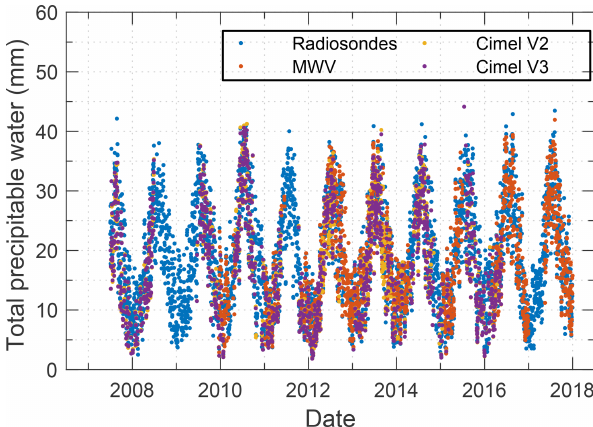
Figure 2. Time series of the daily mean values of the total pre- cipitable water during the period 2007–2017 based on measure- ments from radiosondes (blue dots), a microwave radiometer (or- ange dots), and Cimel sun photometer version 2 (yellow dots) and version 3 (magenta dots) of the